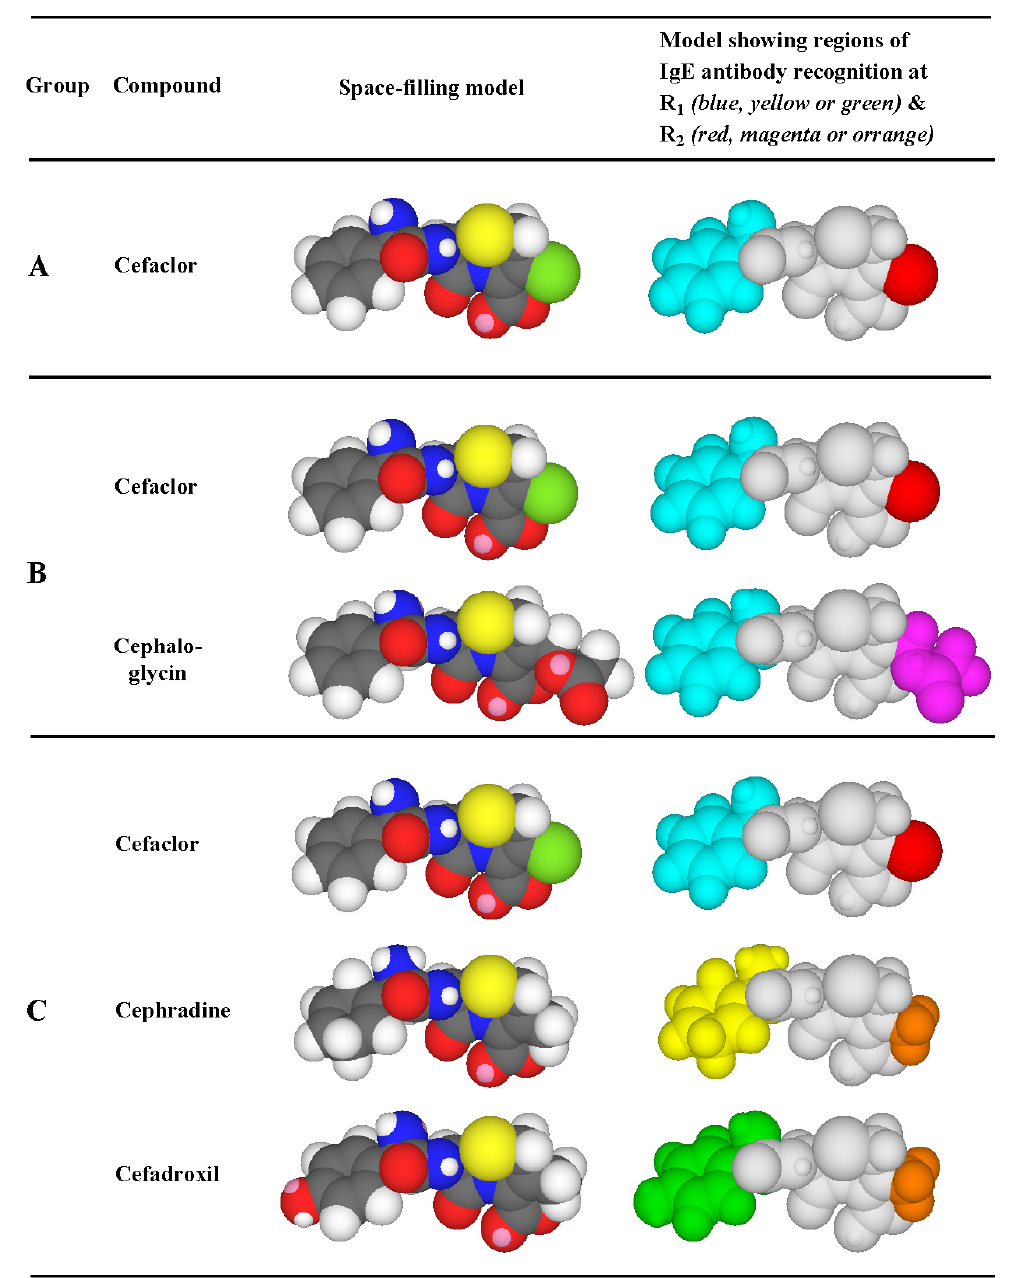
Figure 7. Three-dimensional Corey, Pauling, Koltun (CPK) space-filling models of cephalosporins highlighting the important side chain structural features recognized by IgE antibodies in the sera of patients allergic to cephalosporins. R side chains recognized are 1 shown in blue (aminobenzyl group), yellow (aminocyclohexadienyl group) or green side chains recognized are shown in red (Cl atom), (aminohydroxybenzyl group). R 2 magenta (ester group) or orange (methyl group). From Pham NH, Baldo BA [23]. Reprinted with permission from John Wiley and